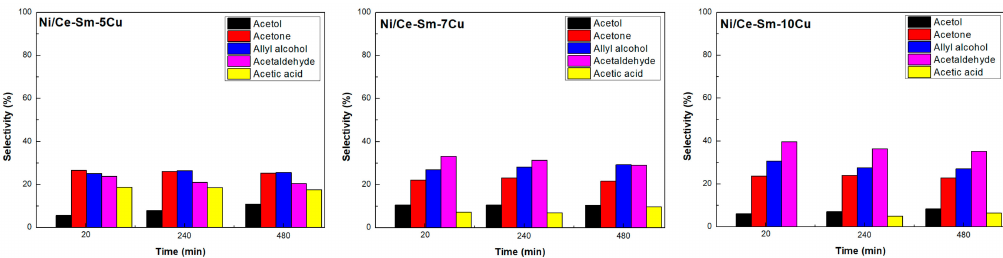
Figure 14. Liquid products selectivity for the Ni/Ce-Sm-xCu (x = 5, 7, and 10 at.%) catalysts [Results obtained for samples tested under experimental protocol